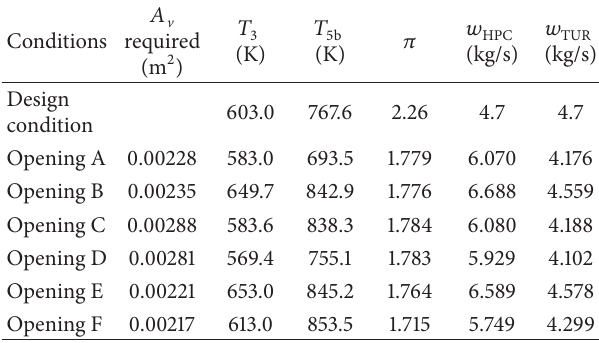
Table 2: Long-term features opening single bypass valve to 0 power